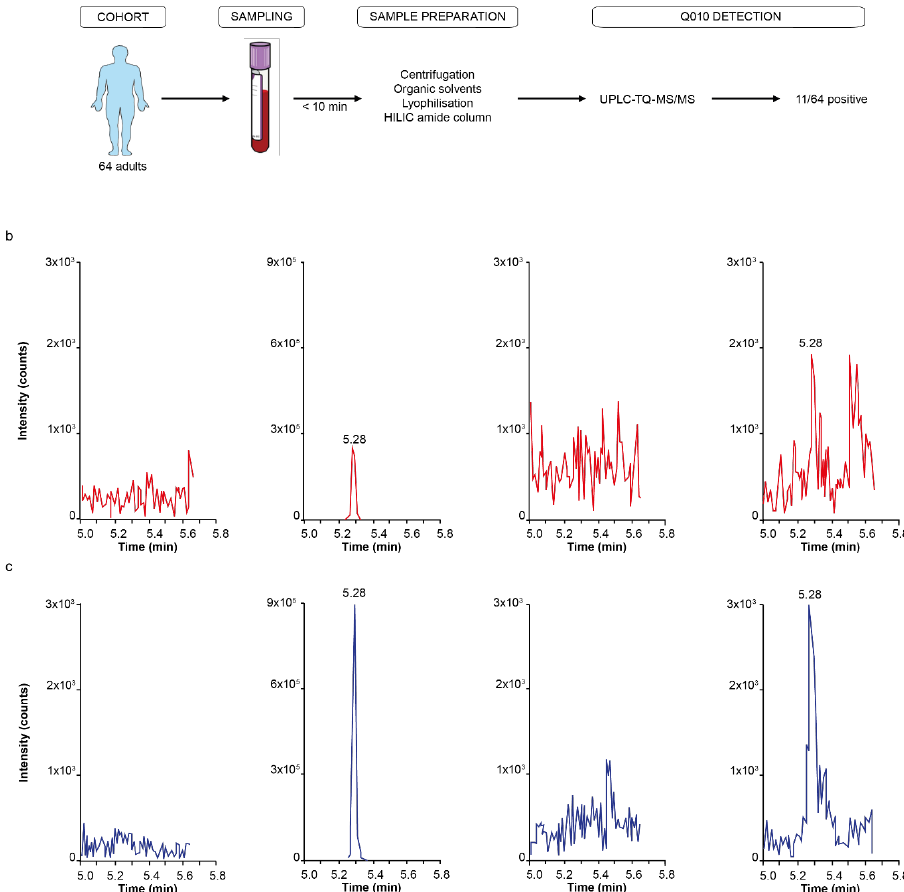
Figure 4. In vivo presence of Q010 quorum-sensing peptide in human plasma. ( a ) Flow chart of human in vivo data acquisition, from sampling of 64 adult plasma samples to LC-MS detection. ( b ) UPLC-TQ-MS/MS parent ( m / z 838.4)- > daughter ( m / z 673.3) qualifier chromatograms of a blank, pre-spiked (1 nM), negative and positive human plasma sample for Q010. ( c ) UPLC-TQ-MS/MS parent ( m / z 838.4)- > daughter ( m / z 539.3) quantifier chromatograms of a blank, pre-spiked (1 nM), negative and positive human plasma sample for Q010.